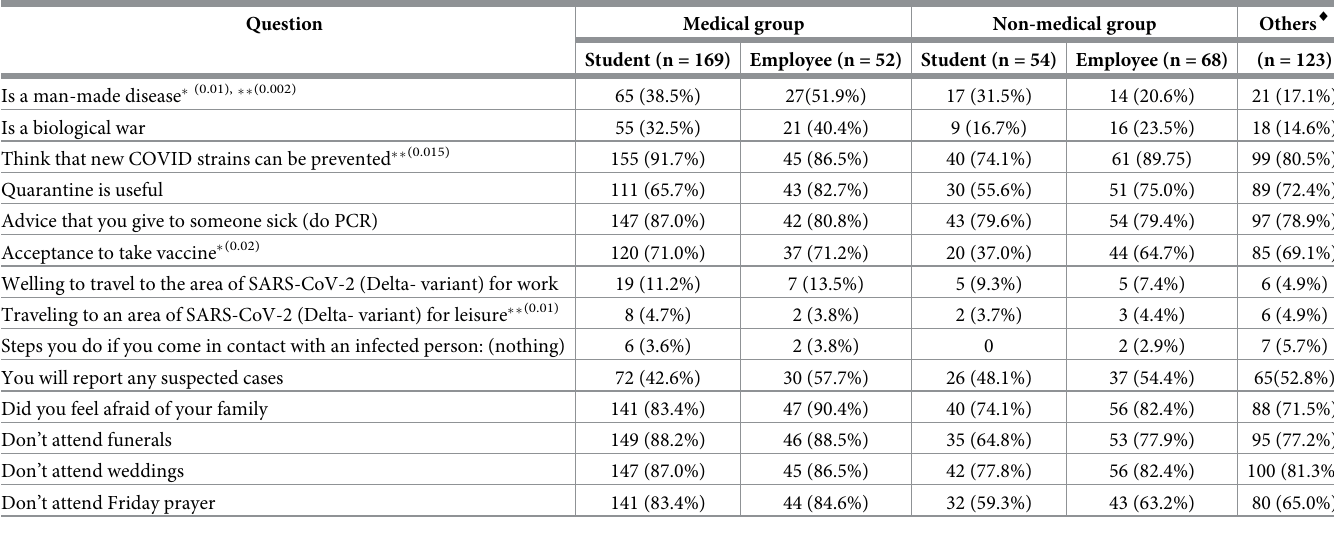
Table 6. Participants’